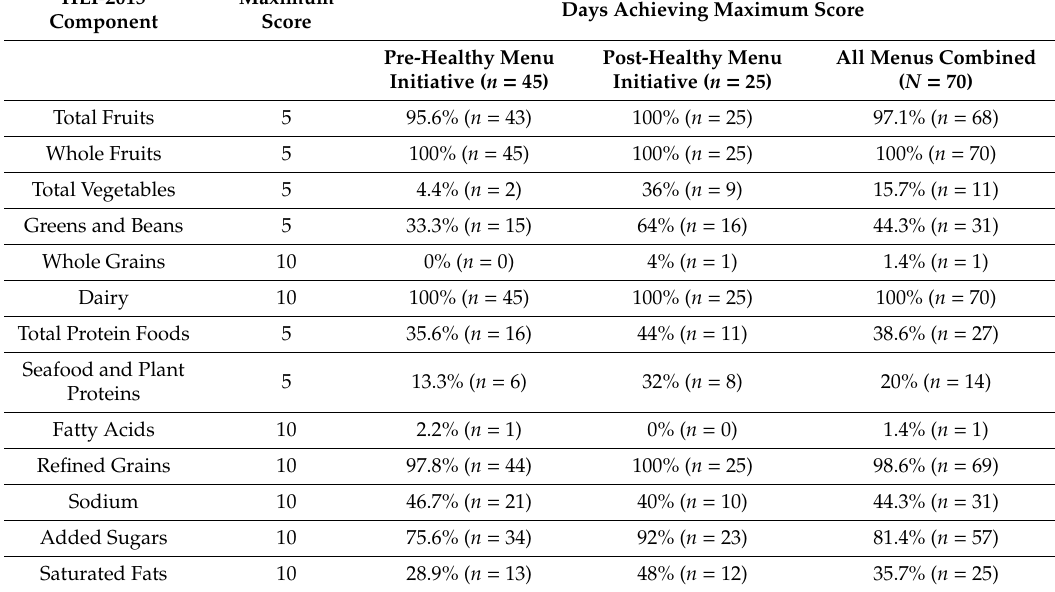
Table 2. Frequency of daily maximum HEI-2015 component scores among pre-initiative, post initiative, and all menus.